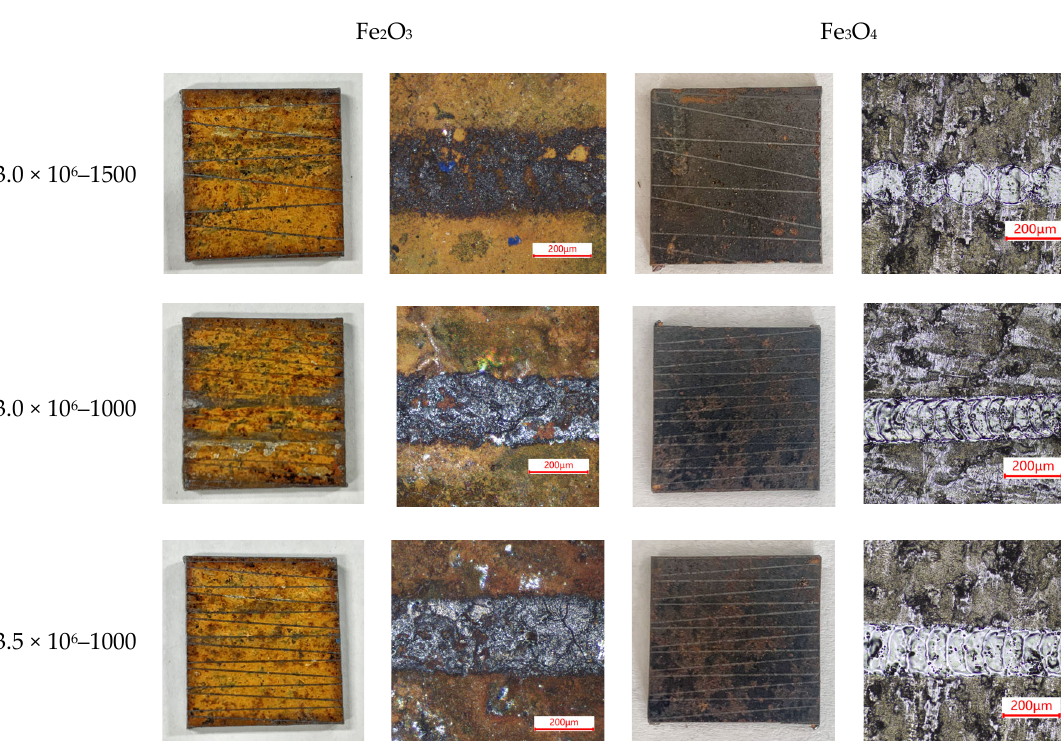
Figure 8. The surface morphology of each layer was cleaned by a single laser time.